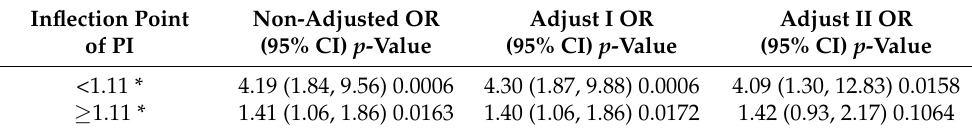
Adjust I OR (95% CI) p -Value